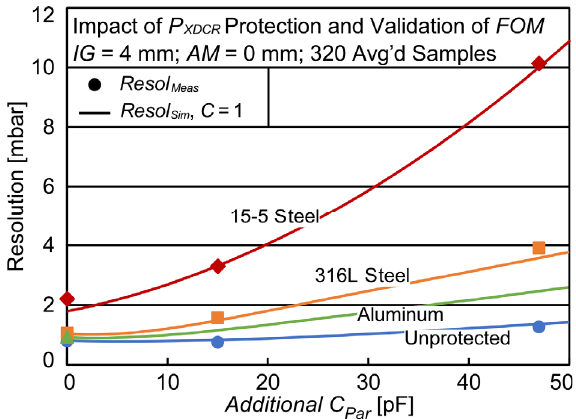
Figure 5. Verification of FOM comparing measured and predicted pressure resolution for varying LC sensor designs.